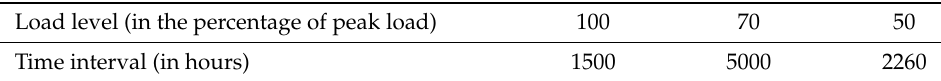
Table A6. Data for load level and load